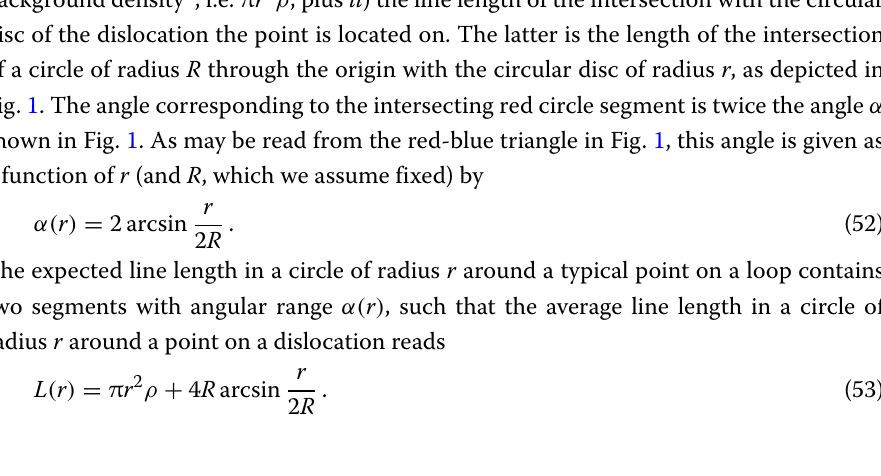
Fig. 1 Sketch employed in the derivation of correlation measures in random distributions of circular loops with radius R . For further details see text